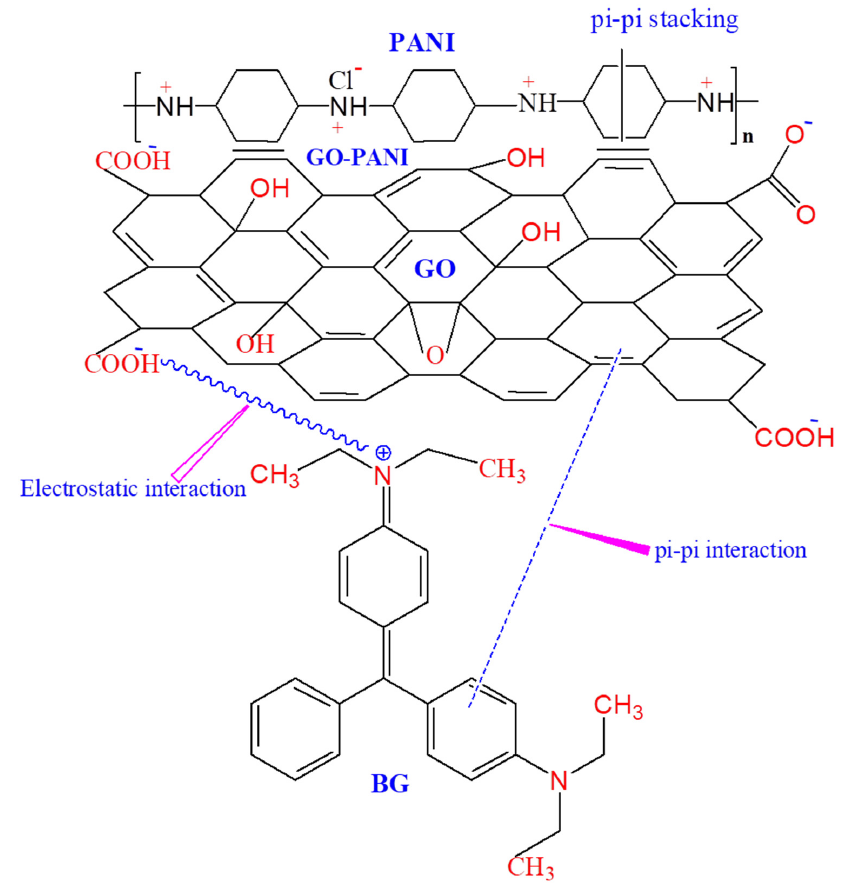
Figure 3. pH plot for BG adsorption on GO-PANI.